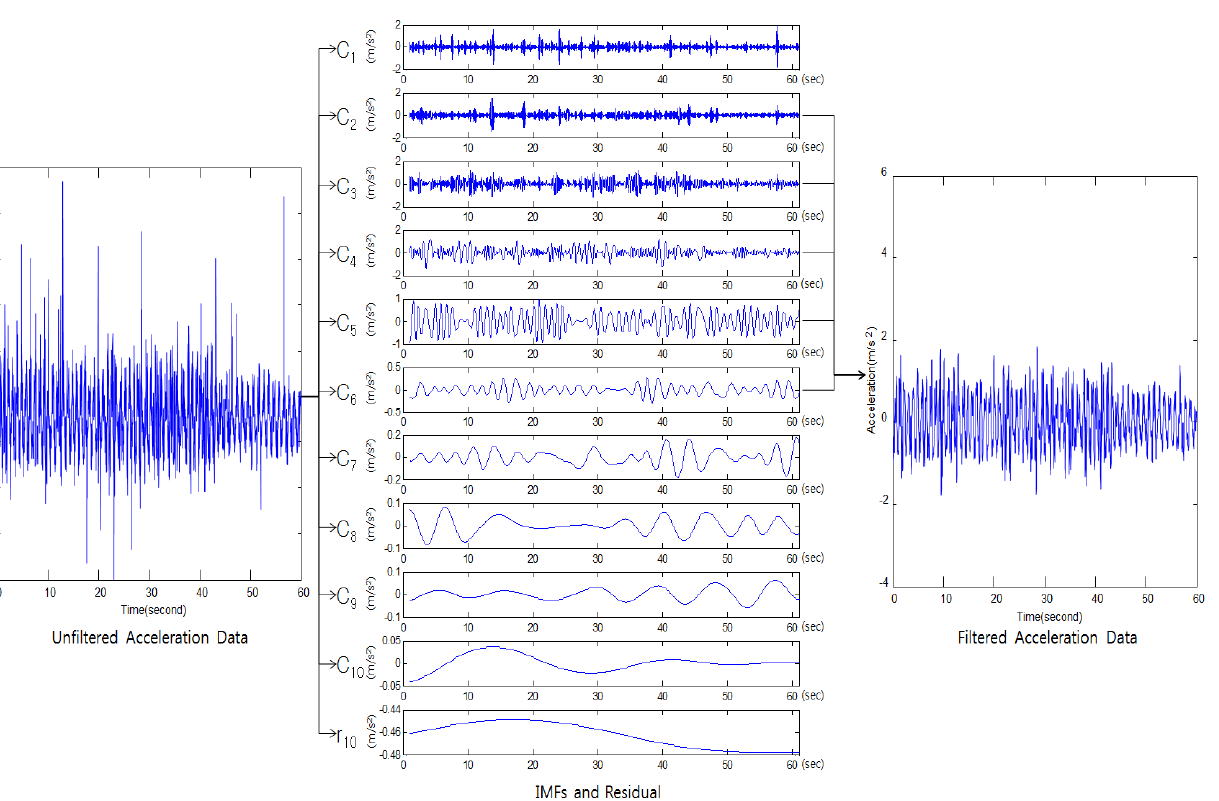
Figure 2. Filtering of the acceleration data using an EMD